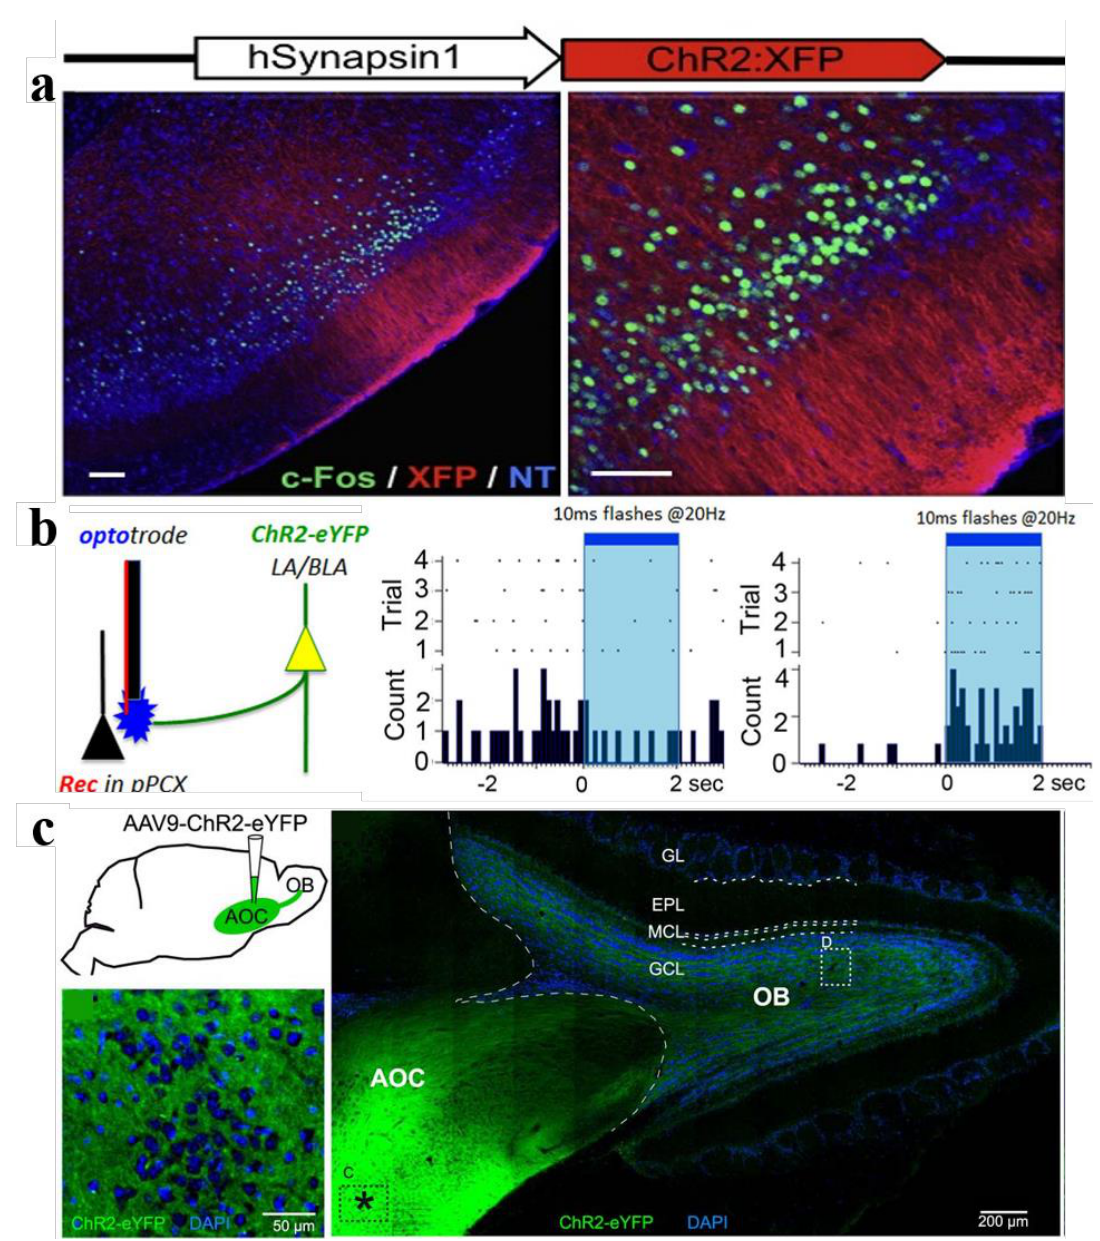
Figure 5. Optogenetic approaches in OC. ( a ) Expression of ChR2 in layers two and three of piriform cortex (PC) [29]. ( b ) Diagram indicating the infected LA/BLA pyramidal cell populations that extend axons into the PCX [114]. ( c ) Schematic representation of AAV2/9-ChR2-eYFP injection into the AOC and cortico-bulbar ChR2 axons targeting the OB and the expression of ChR2 in the AOC [108] . Reproduced with permission from ( a ) [29], Copyright 2011 Elsevier; ( b ) [117], Copyright 2014 LaLuniere; ( c ) [111], Copyright 2016 Society for Neuroscience.